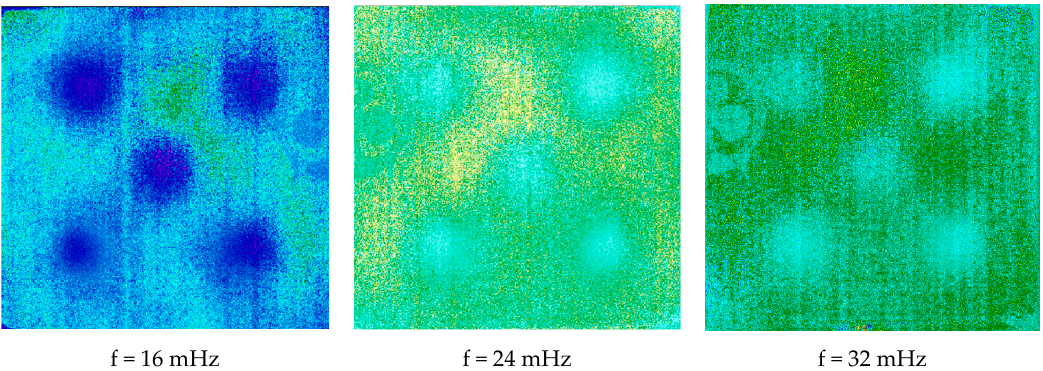
Figure 19. Phase images of the calculated harmonic response (at f = 16 mHz, f = 24 mHz and f = 32 mHz). f = 32